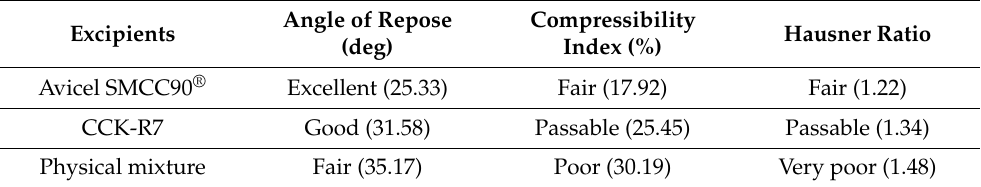
Table 4. Corresponding flowability parameters (USP 42) of three types of excipients. Excipients